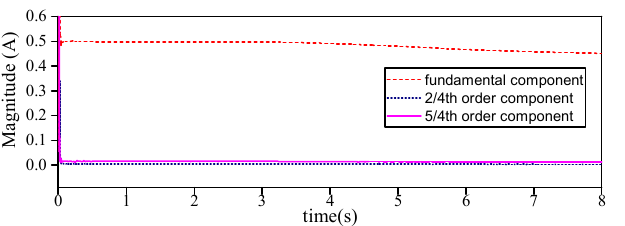
Figure 10. Magnitudes of fundamental and harmonic components in current for partially demagnetized PMSM under nonstationary conditions (experiment).